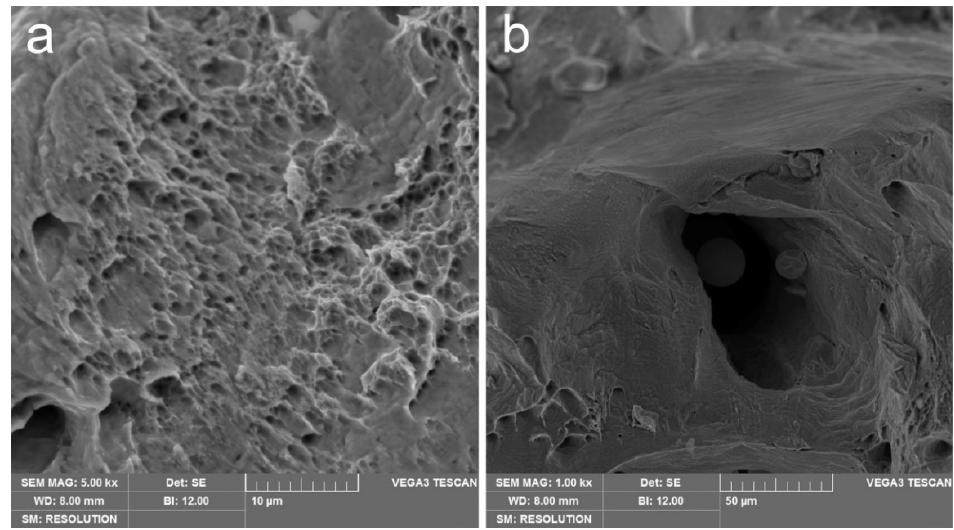
Figure 7. SEM of Cu-0.5Cr bronze after the tensile test: typical dimple structure ( a ) and pore with unmelted particles inside ( b ).